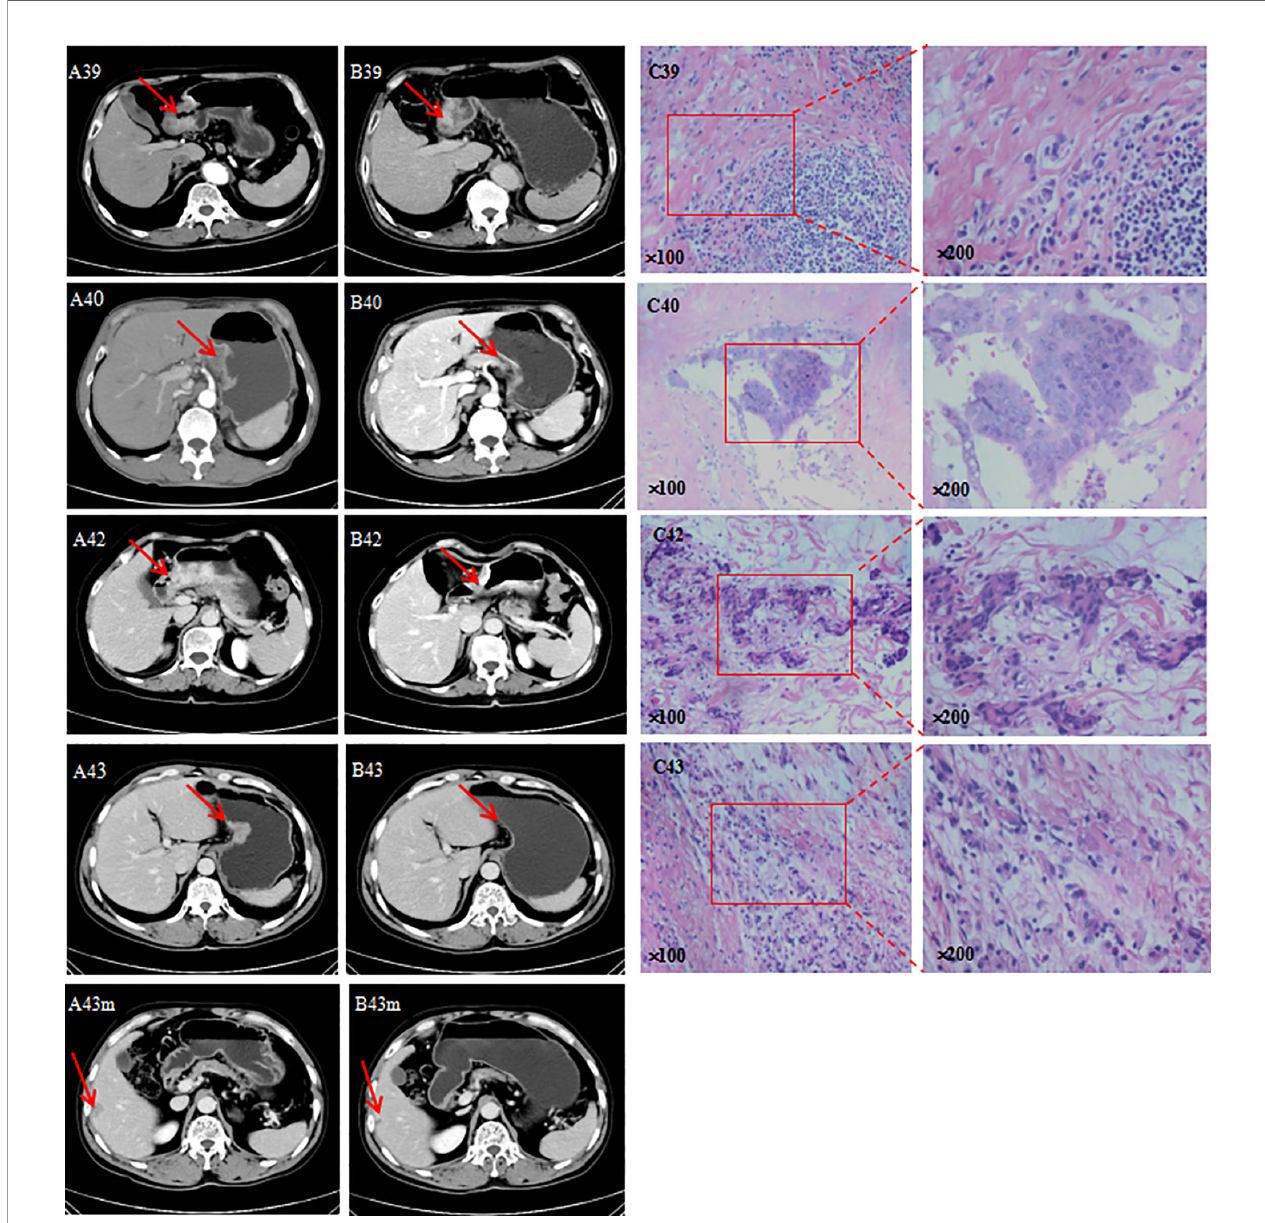
FIGURE 6 | (A) CT before neoadjuvant chemotherapy; (B) CT after neoadjuvant chemotherapy; m, liver metastasis; (C) image pathology after neoadjuvant